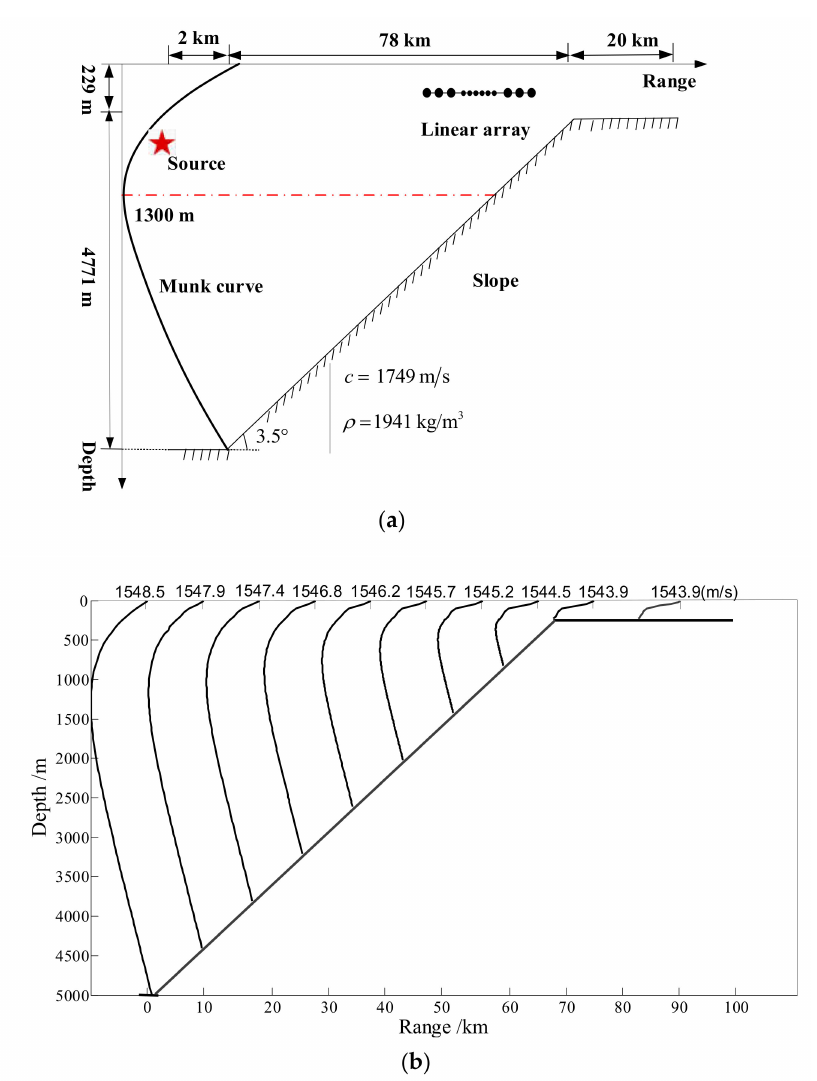
Figure 6. The upslope waveguide: ( a ) Simulation environment and parameters; ( b ) The SSPs of the continental slope